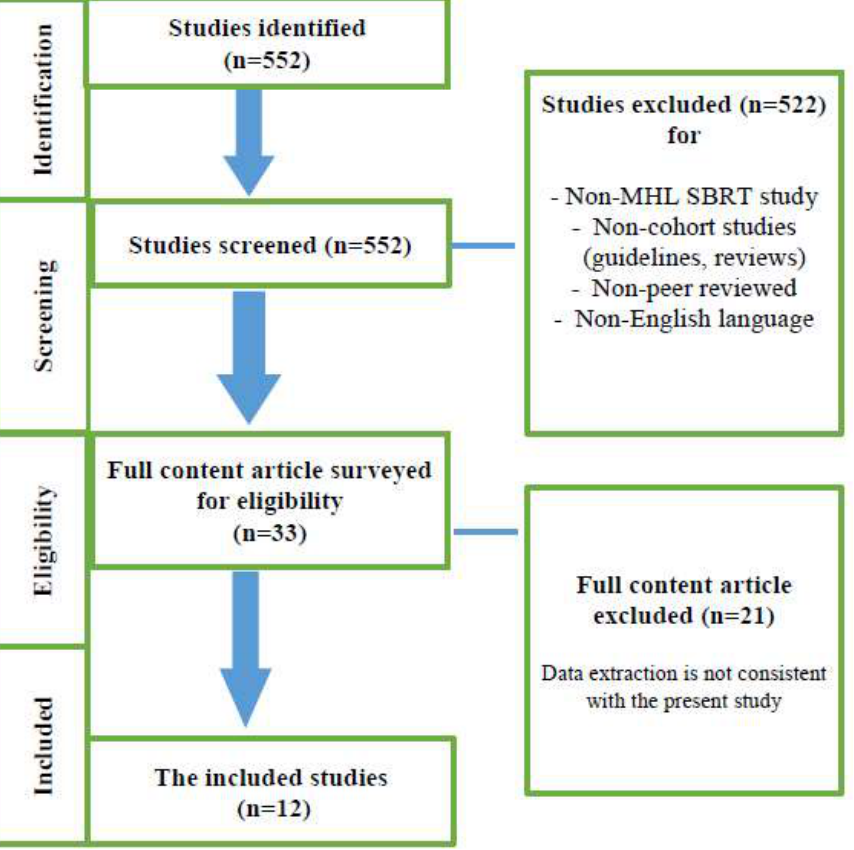
Figure 1. The flowchart for screening the eligible studies. Abbreviations: MHL: mediastinal-hilar lymph node; SBRT: Stereotactic body radiation therapy.